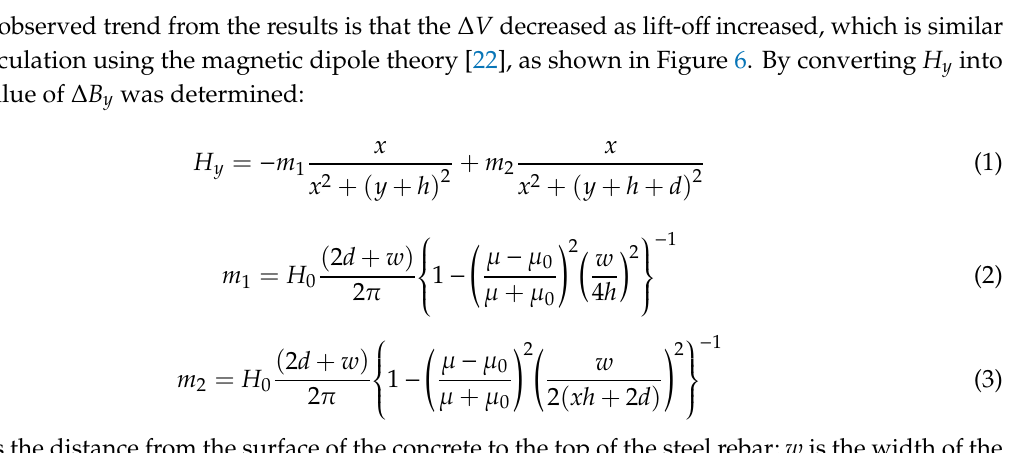
Figure 7. Estimated defect location based on the results. A loss in accuracy occurs as lift-off increases. In summary, an MFL measurement system consisting of two MTJ sensors in a full bridge circuit configuration was constructed. This system demonstrated similar behavior to the theoretical calculation, whereby the magnitude of the leaked magnetic flux decreases as the lift-off increases. Based on the results, the system showed the capability to detect the defects (cracks) in reinforced concrete at high lift-off values.